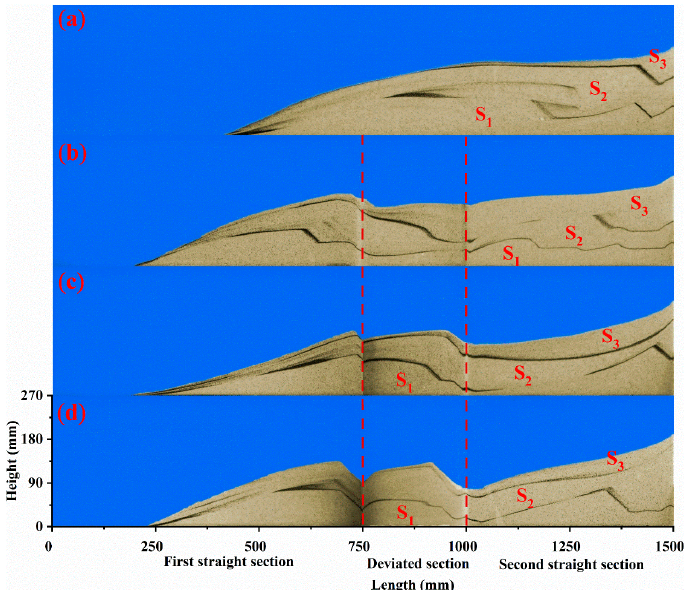
Figure 5. Snapshots of 40/70 mesh sand dunes in four channels at the stable status at L 1 /L = 0.5, Re = 3311, and S = 0.16, front view: ( a ) The straight channel, θ = 180°; ( b ) The curving channel, θ = 135°; ( c ) The curving channel, θ = 90°; ( d ) The curving channel, θ = 45°. The curving pathway significantly affects particle transport behaviors compared to